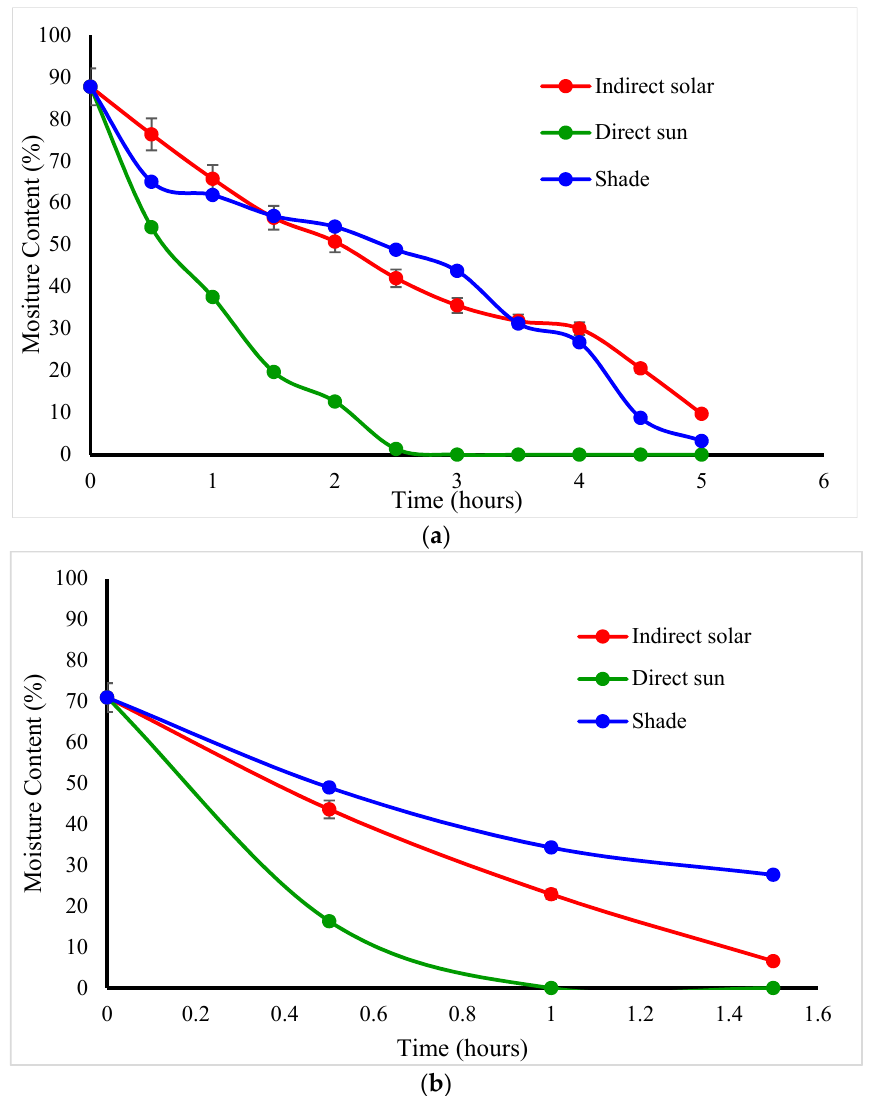
Figure 2. The moisture content reduction in ( a ) Basil and ( b ) Mint during winter.